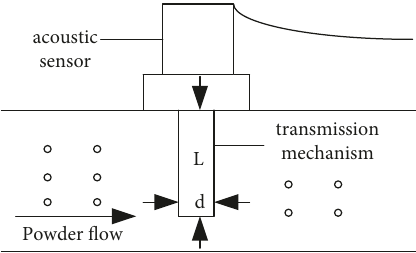
Figure 2: Schematic diagram showing the layout of acoustic sensor.